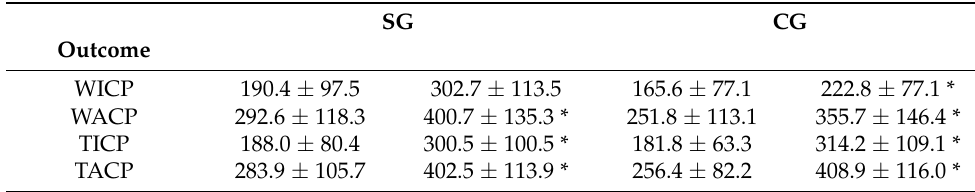
Table 2. Pain outcomes during walking